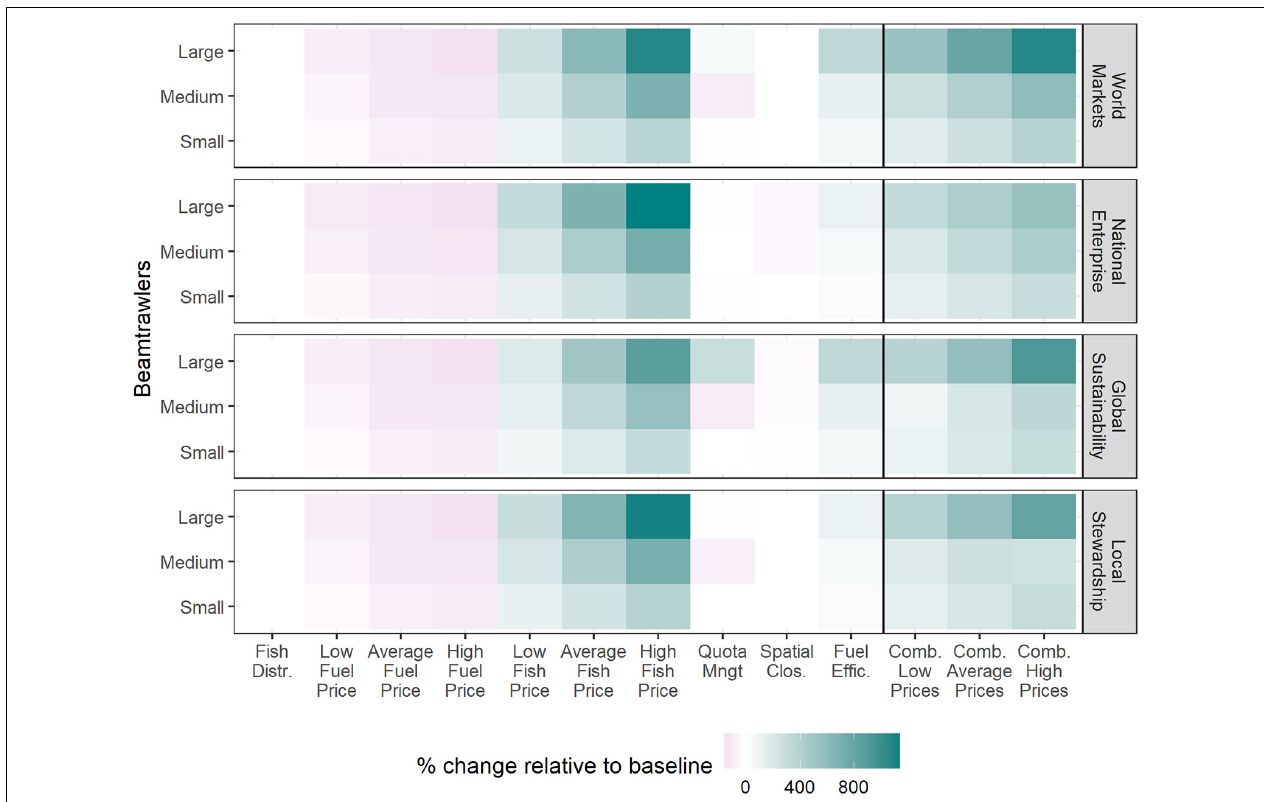
FIGURE 7 | Relative change of NPV of profit in the mid-century (2040–2050) per fleet per scenario, disaggregated per factor, compared to the baseline. Factors include Fish Distr.: change in species distribution, fuel/fish price: low, average and high fuel/fish price trends as defined in Table 1 , Quota Mngt: different FMSY target to calculate sole and plaice quota and quota trading rules; spatial Clos,: marine spatial planning; Fuel Effic.: increase in fuel efficiency; Comb. Low/Average/High Prices: scenarios combining all the factors with low/average/high fish and fuel prices as defined in Table 1